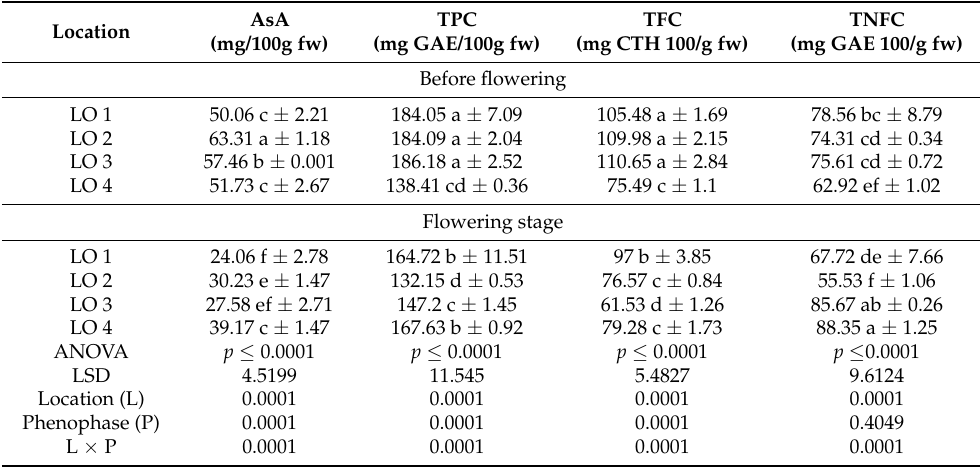
Table 4. Specialized metabolites content of wild garlic leaves from different